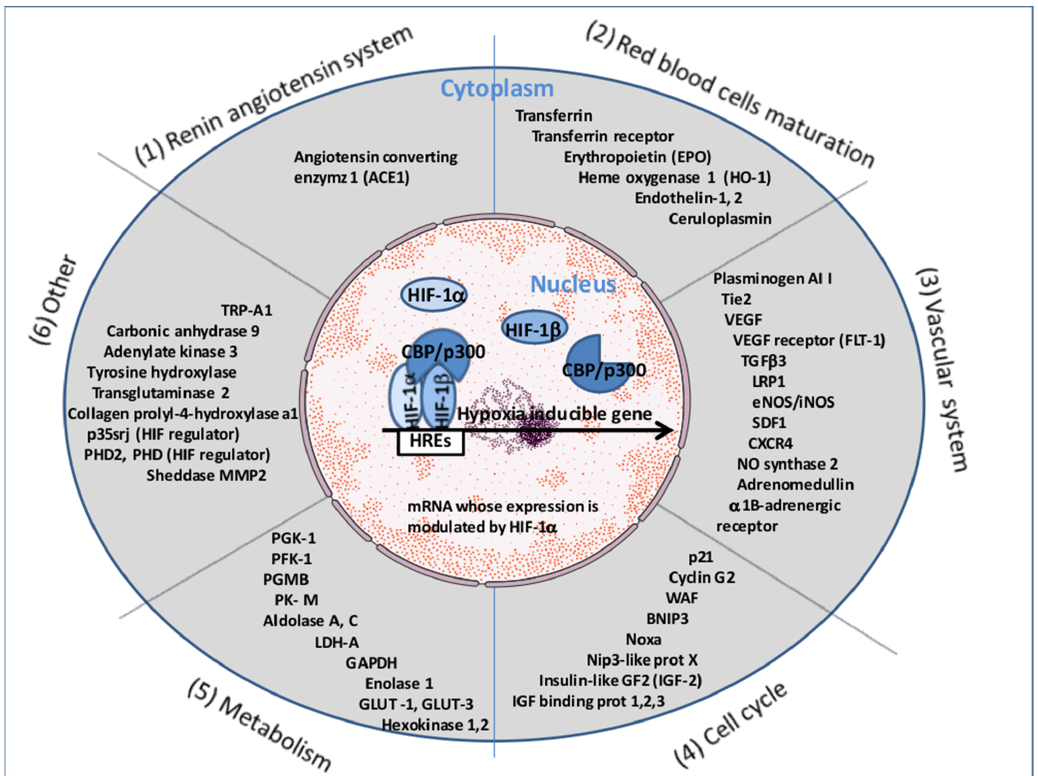
Figure 3. Representative list of cellular genes upregulated by HIF ‐ 1. HIF ‐ 1 α is considered a ‘master regulator’ type of transcription factor capable of controlling the expression of a multitude of